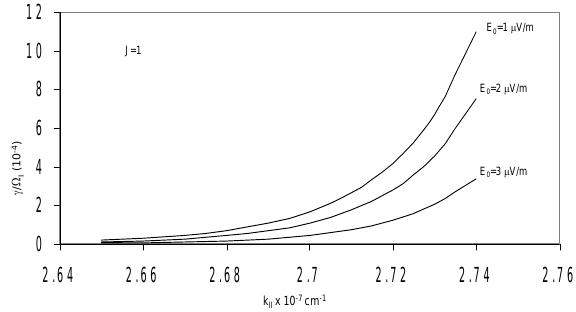
Fig. 8. Variation of perpendicular resonant energy Wr ⊥ ergcm 39 versus wave vector k II cm − 1 for different values of parallel electric Fig. 8 Variation of perpendicular resonant energy Wr ⊥ ergs-cm versus wave vector k II cm-1 for different values Fig:-5 Variation of perpendicular resonant energy W ergcm versus wave vector k II cm -1 for different values of parallel r ⊥ of parallel electric field E 0 , and distribution index J = 1. field E 0 , and distribution index J=1. ric field E 0 ,and distribution index J=1.elect